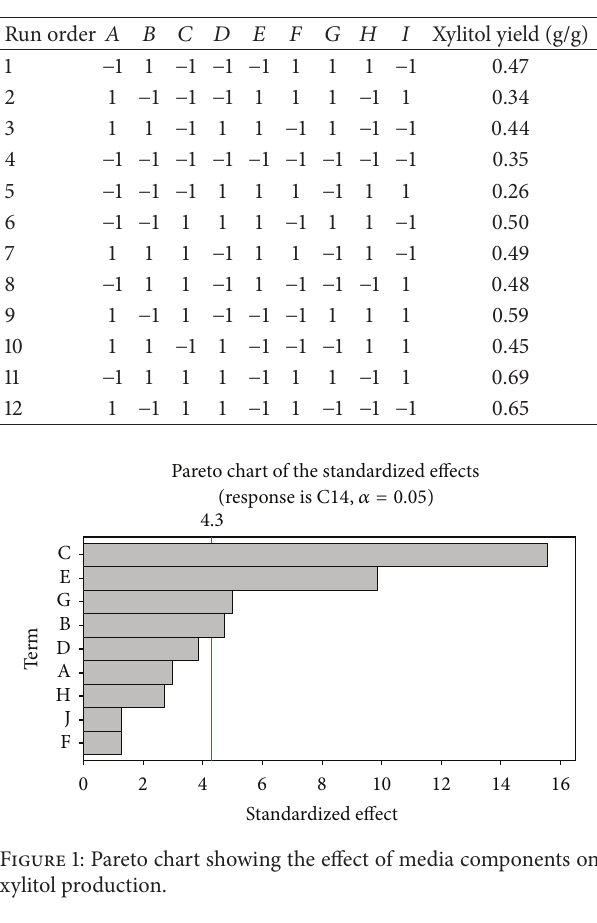
Table 1: Plackett-Burman experimental design for nine variables.